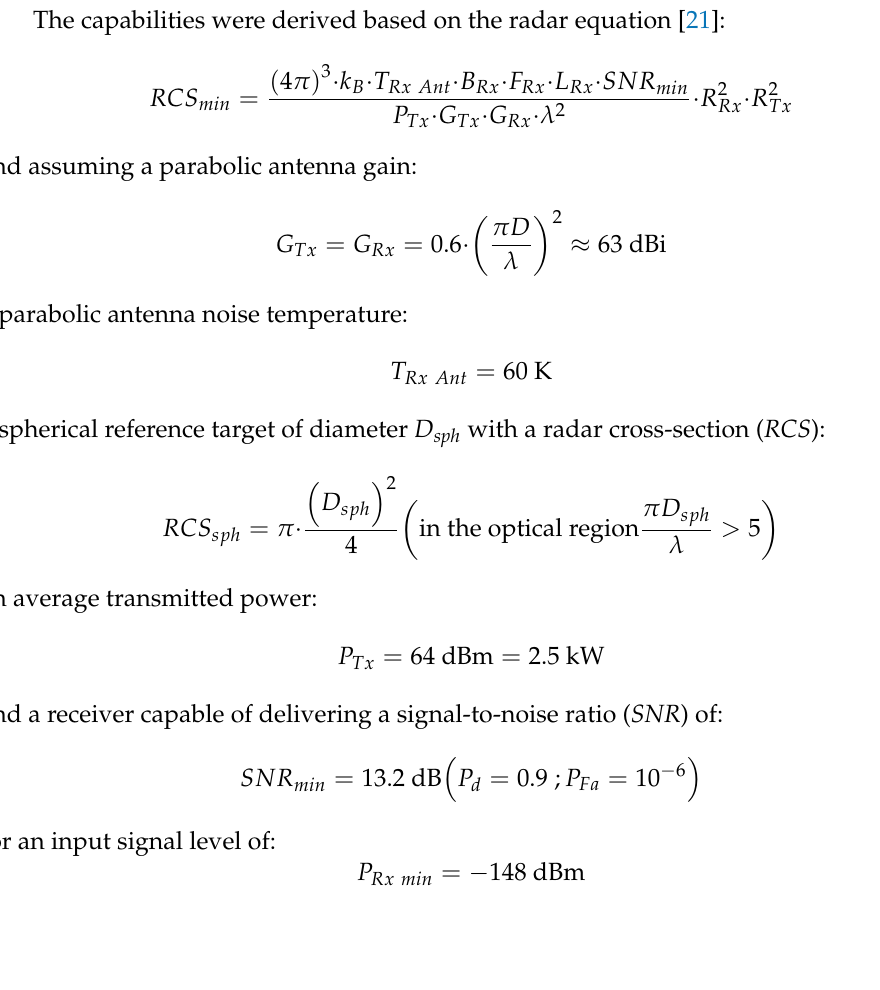
Figure 4. Estimation of minimum size of the target detected in CW mode at two elevation angles (90 and 20 deg.) compared to requirements.